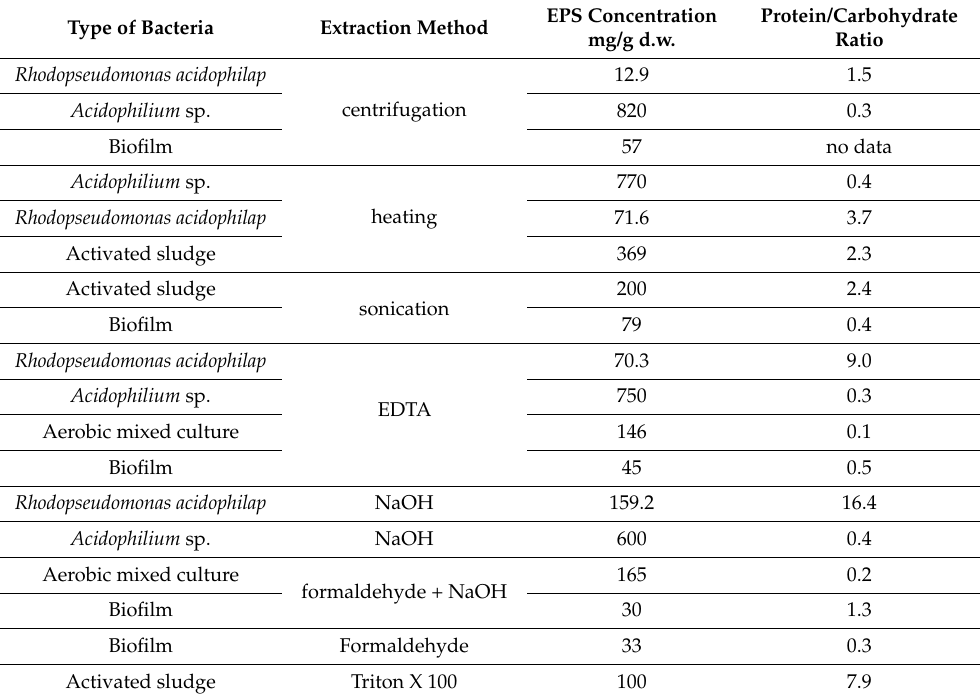
Table 3. Comparison of the total EPS extracted from various cultures by various extraction methods (based on the data collected by Nouha et al. [42]).